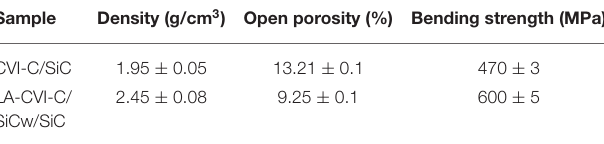
of fibers and fiber bundles were pulled out, and the length of fiber extraction ranged from tens to hundreds of